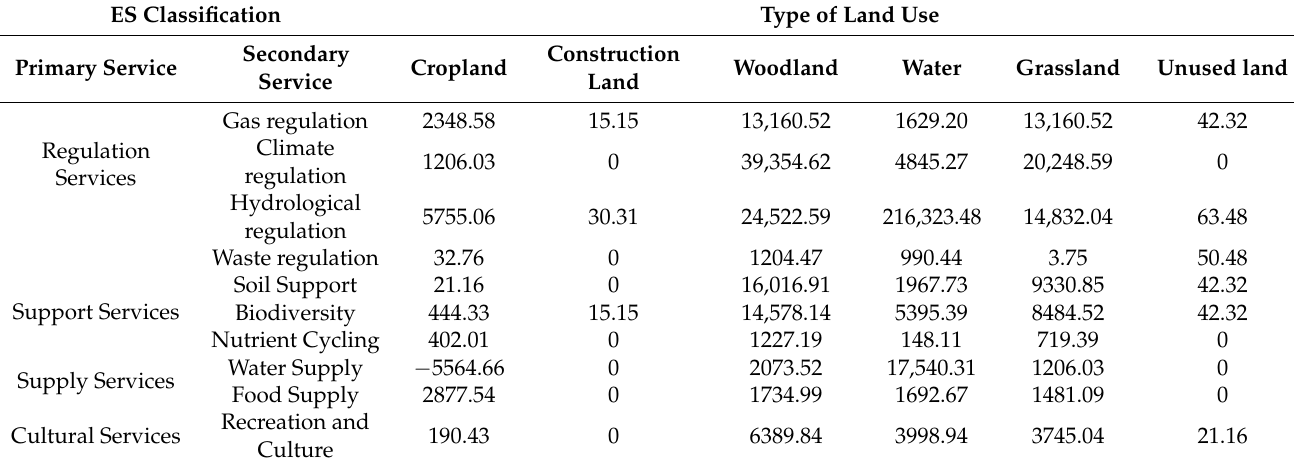
Table 5. Ecosystem service equivalent value per unit area of the GHM-GBA.